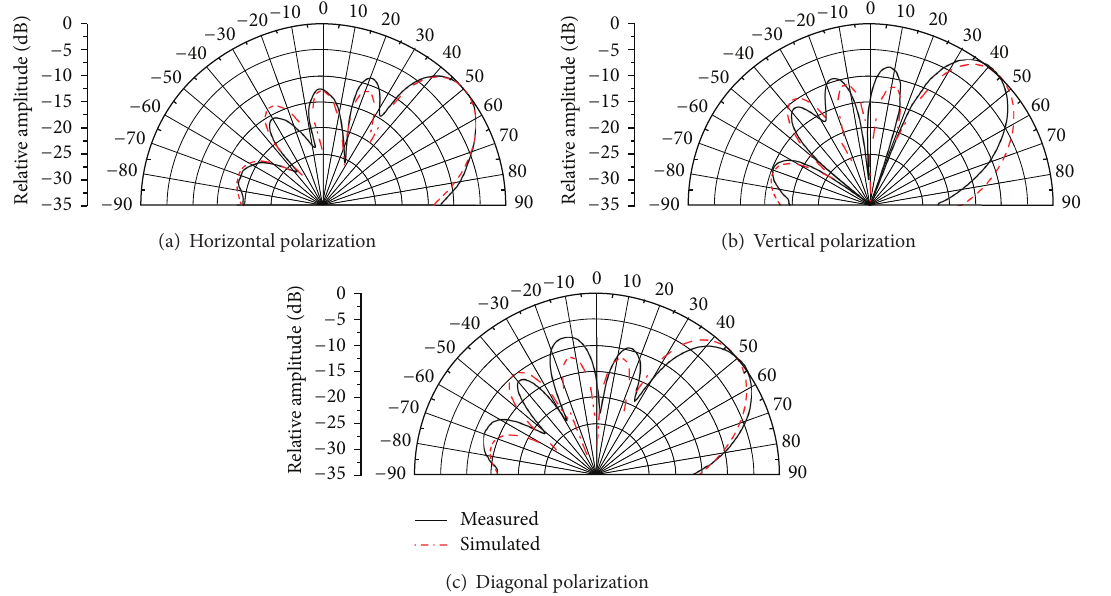
Figure 19: The polarization tracking patterns measured at 12.5 GHz with beam scanned to 50 ∘ .